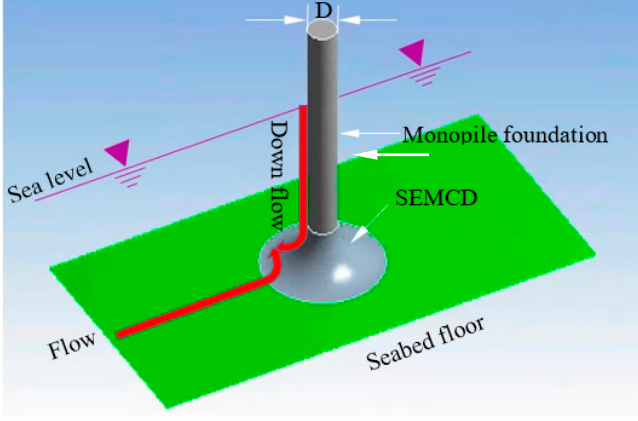
Figure 1. Schematic diagram of the proposed scour-countermeasure device (SEMCD).